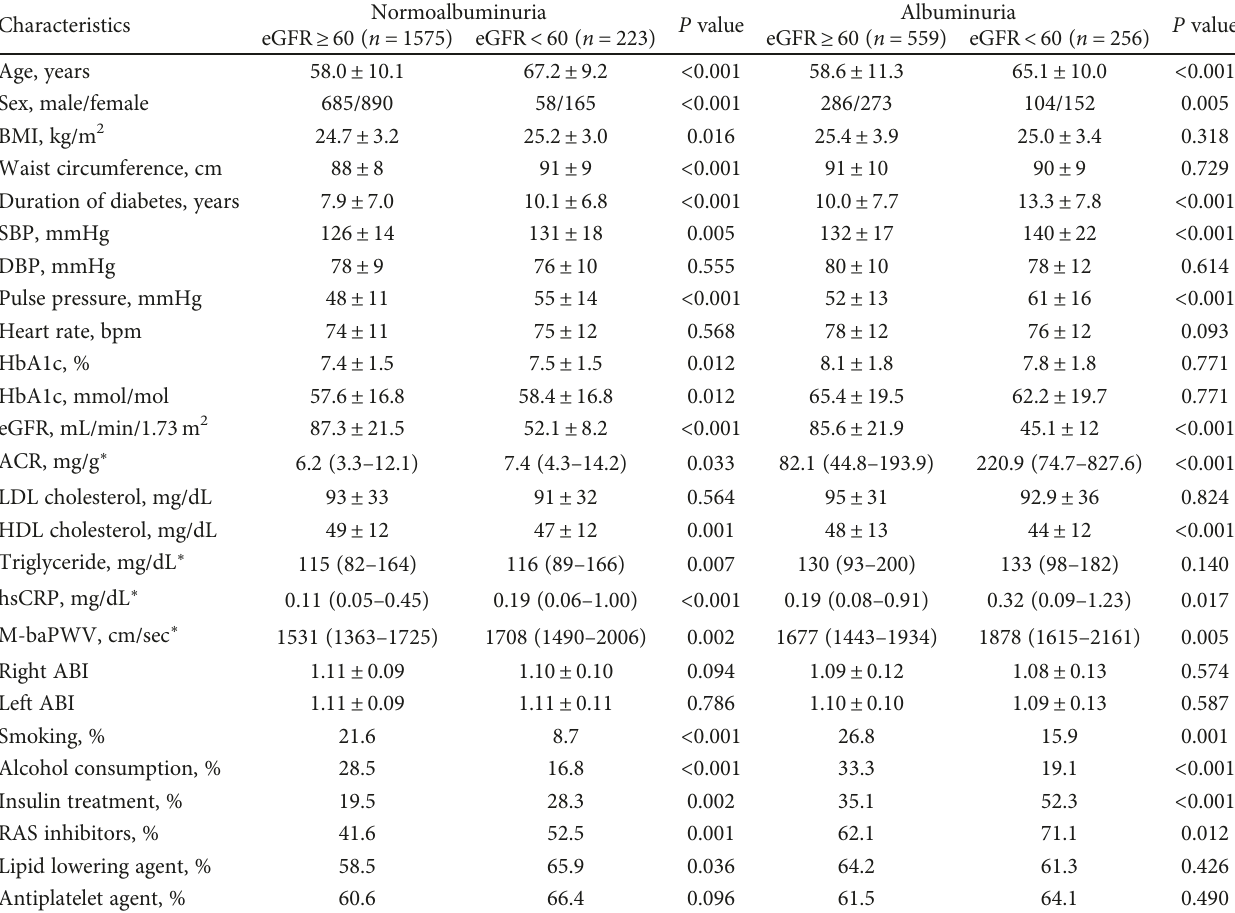
Table 1: Comparison of clinical characteristics according to albuminuria and eGFR